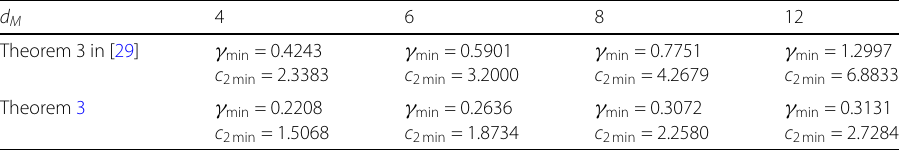
Table 1 Optimal values for different time-delay upper bound d M when ¯ μ = 0 d M